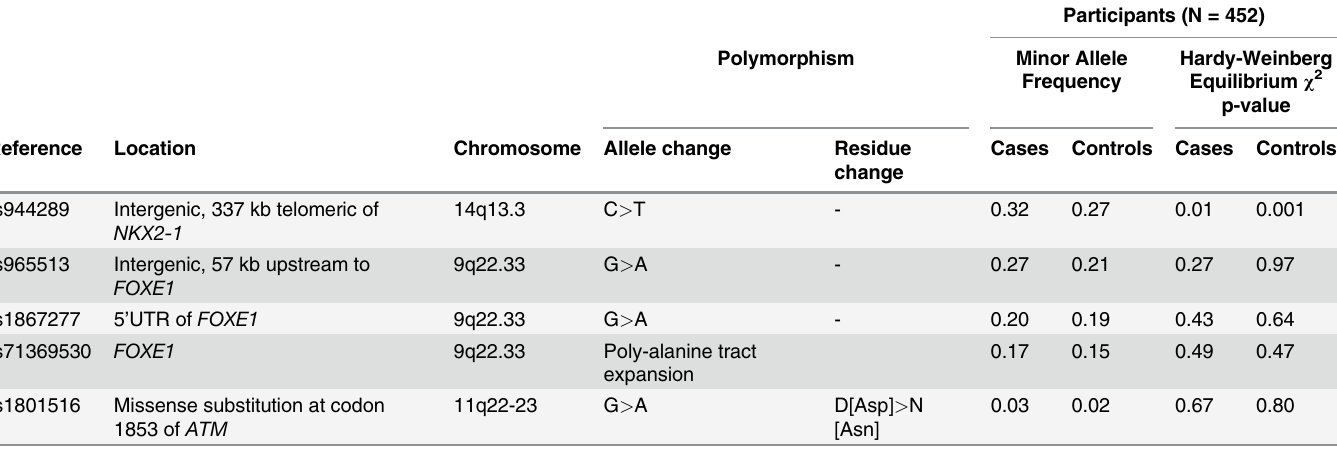
Table 1. Description of the five studied